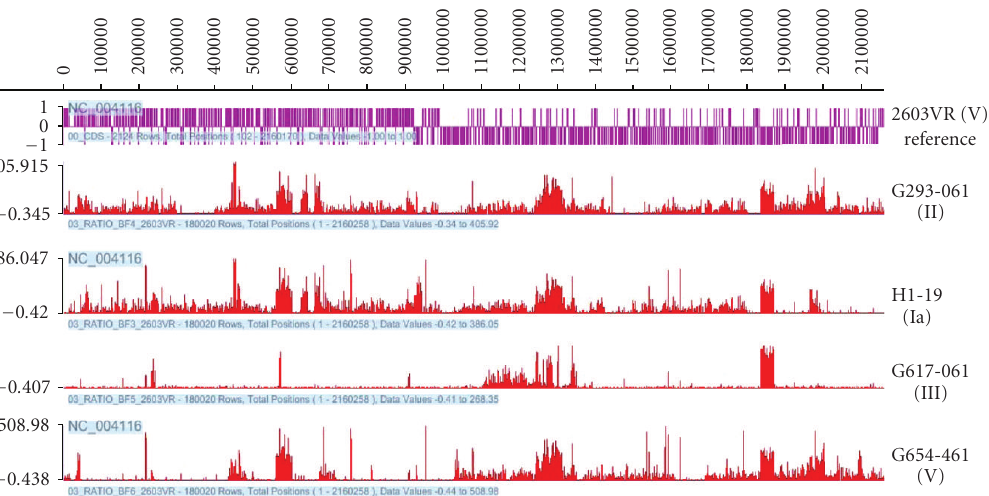
Figure 1: Locations of variable probes sequences identified within genomes of group B Streptococcus strains 2603VR in comparative genomic hybridization using each of the four tester strains of group B Streptococcus